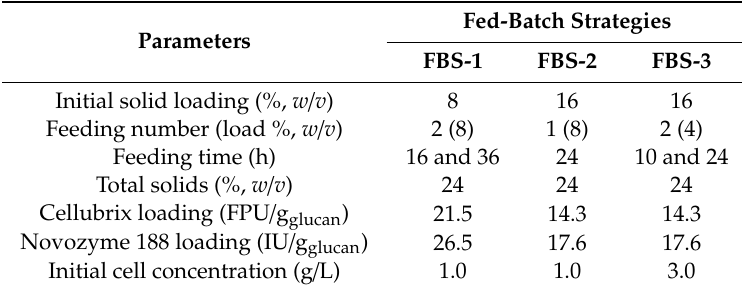
Table 3. Summary of the conditions used for the fed-batch SSF process with the di ff erent feeding strategies of pre-treated rice straw in the VBM reactor under optimized conditions (41.5 ◦ C, 18 glass spheres) at 200 rpm.